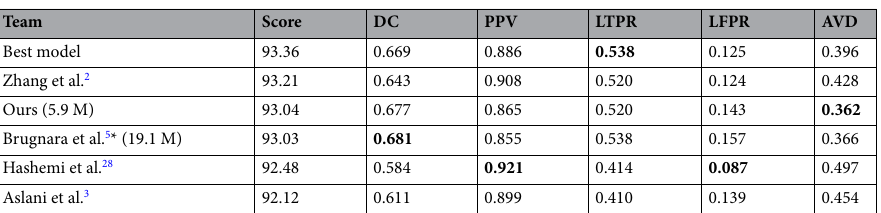
Table 3. Performance of the multi-arm U-Net on the test set of the ISBI 2015 challenge. The highest or lowest values are in bold. *3D nnU-Net trained for MS T2 lesion segmentation. The number of model parameters for multi-arm and nnU-Net is provided within parenthesis. AVD absolute volume difference, DC dice coefficient, LFPR lesion false positive rate, LTPR lesion true positive rate, PPV positive predictive